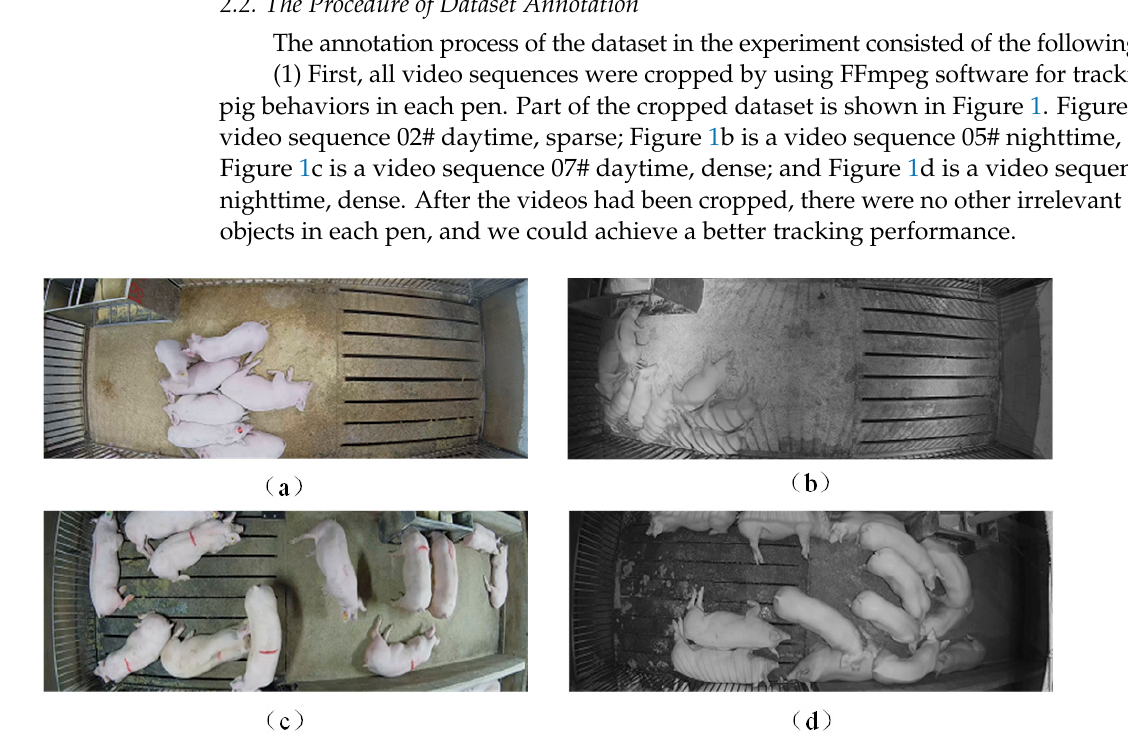
Figure 1. Part of the cropped dataset, ( a ) video sequence 02#, ( b ) video sequence 05#, ( c ) video sequence 07#, and ( d ) video sequence 10#.